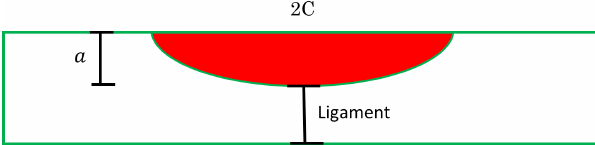
Figure 6. Diagram of the remaining ligament in a semi-spherical